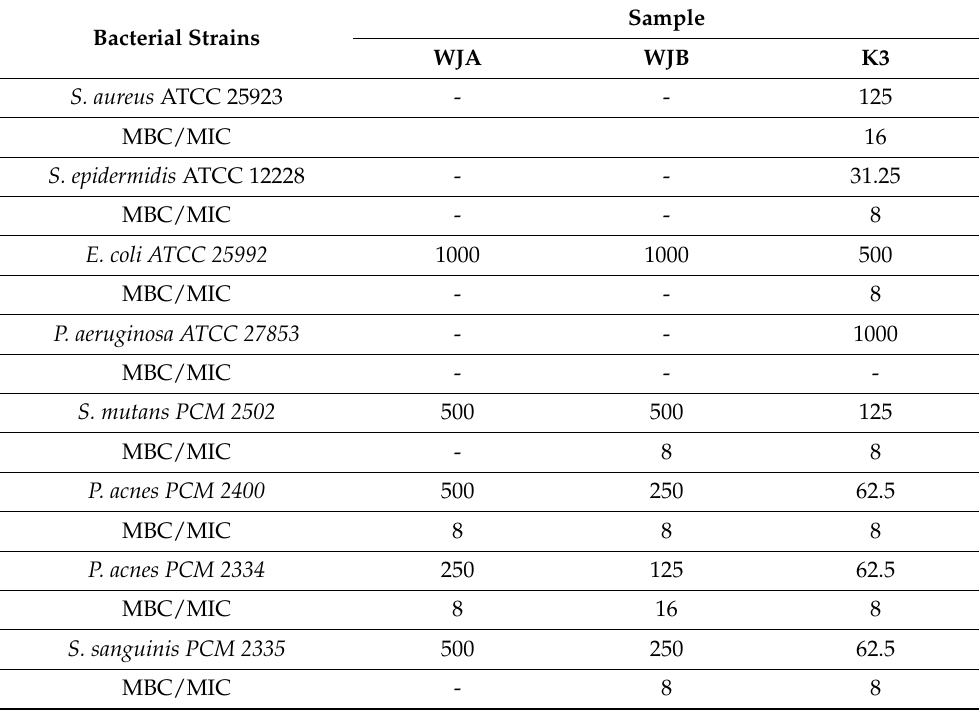
Table 6. Minimum inhibitory concentration (MIC ( µ g/mL)) and MBC/MIC ratio as the antibacterial activity of the E. japonicum